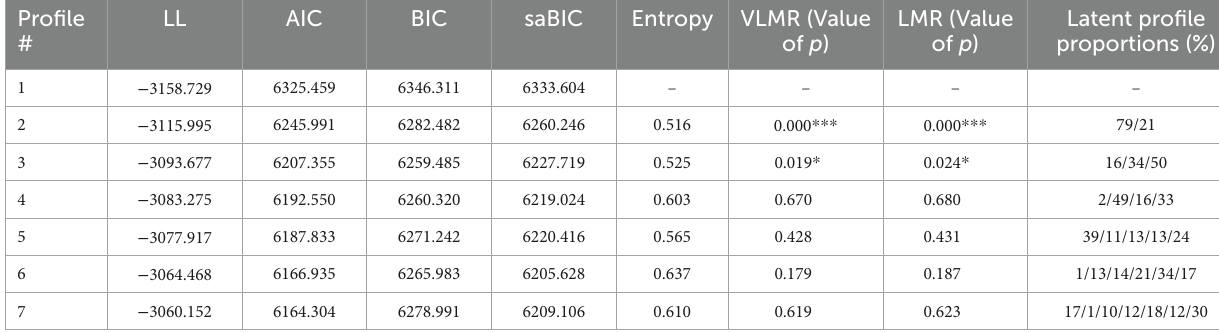
TABLE 3 Model fit statistics for latent profile